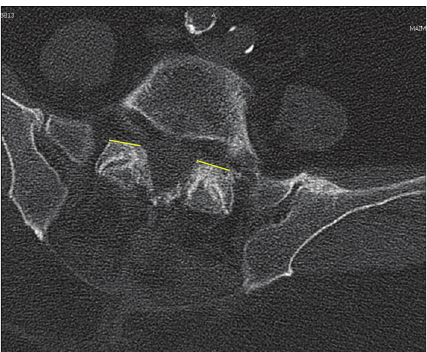
Figure 7: Postoperative axial CT scan image at the level of the facet joint demonstrating partial removal of the upgoing